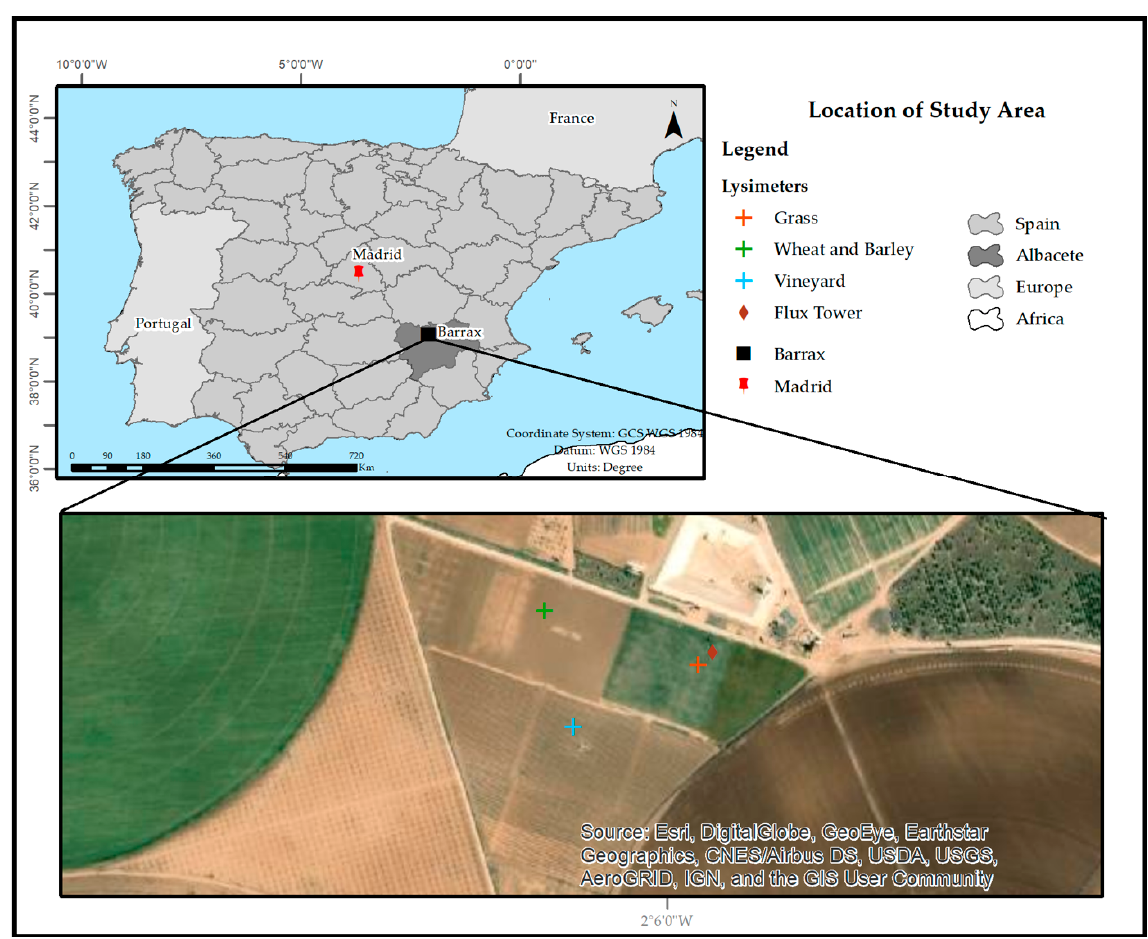
Figure 2. Barrax area location in Albacete, Spain, and Europe. Lysimeters and tower flux points are shown on the map.